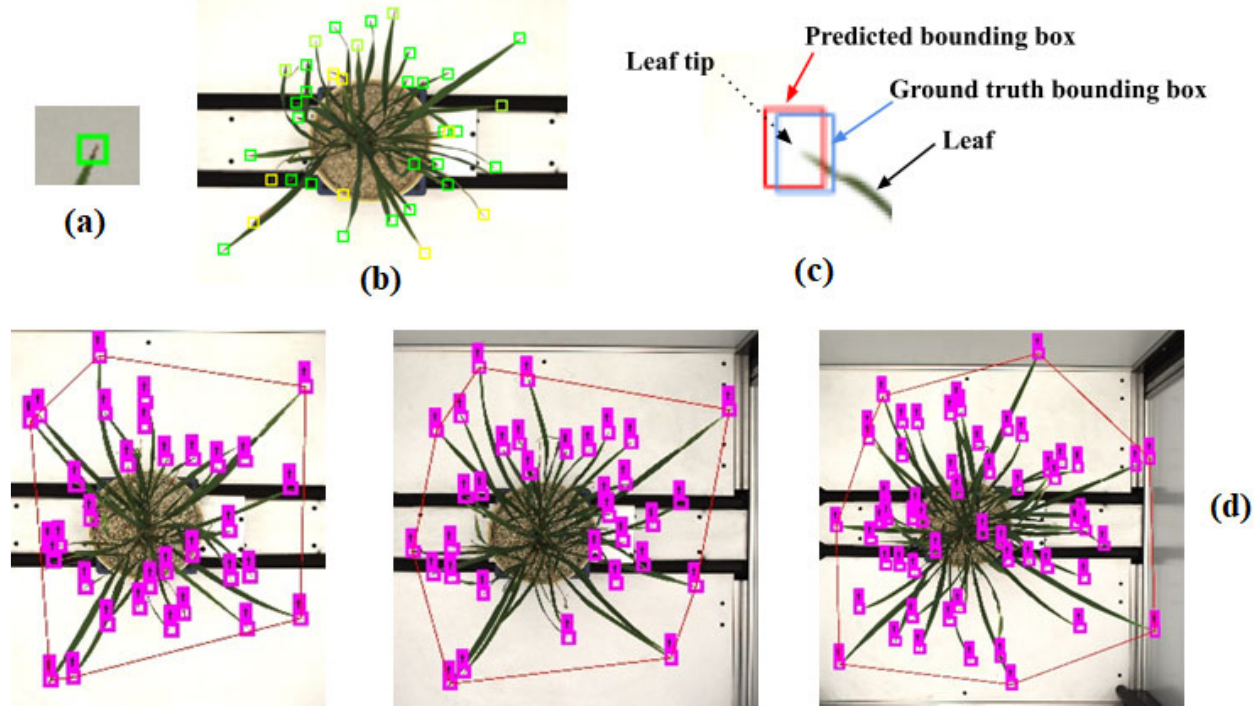
Figure 6. ( a ) Leaf tip, bounding box annotation for the leaf tip, ( b ) labelling of the leaf tips in a rice plant, ( c ) leaf tip at the center of the bounding box coordinates, ( d ) temporal increase in the number of leaves, and thus convex hull area (CHA); the number of leaves per convex hull area is a potential ‘temporal trait’ to understand the plant type, growth and stress behavior.